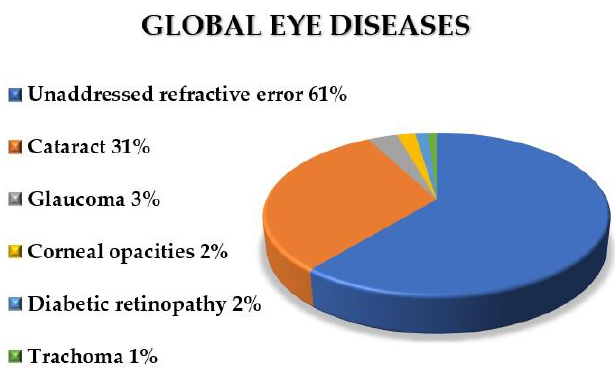
Figure 2. Incidence rate of the most conventional eye diseases, according to the WHO (2019) [21] .